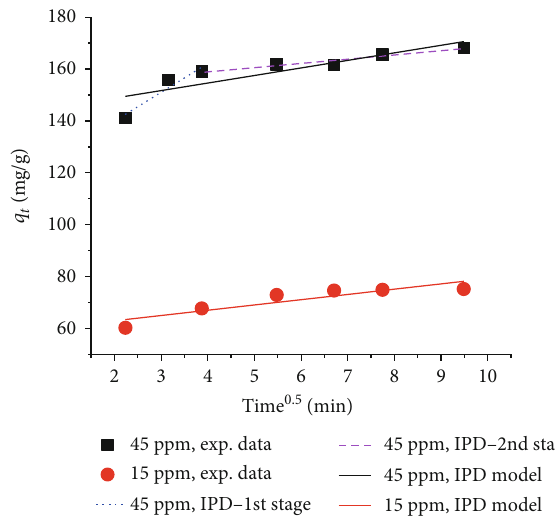
Figure 7: Webber-Morris intraparticle di ff usion plot for the adsorption of CV onto PACK (see Figure 4 for